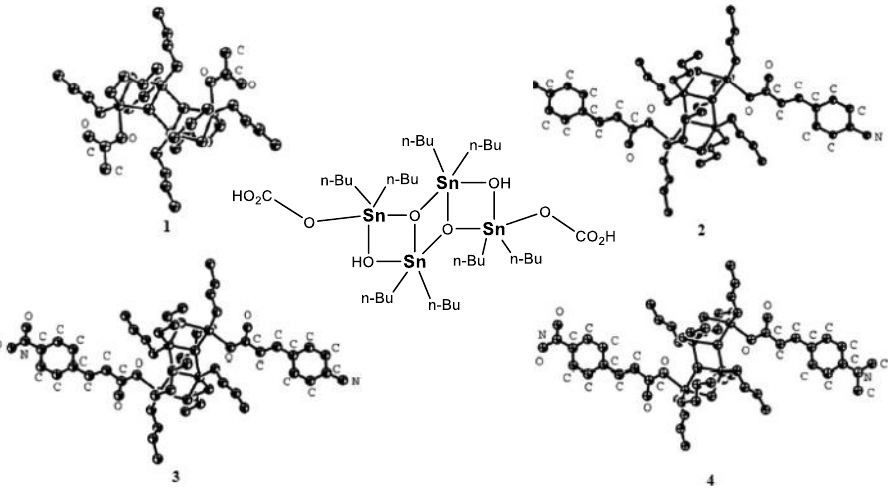
Figure 44. Computationally calculated species for pseudocage, oxo-bridged tin complexes with